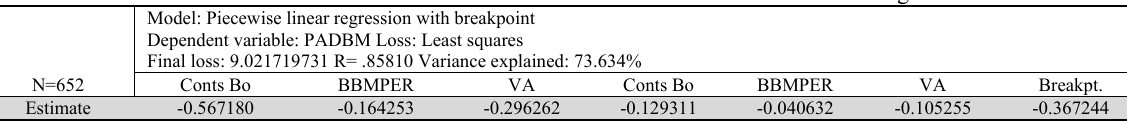
The result of two disturbance variables affects economic resilience variable Z Piecewise linear regression Model: Piecewise linear regression with breakpoint Dependent variable: PADBM Loss: Least N=652